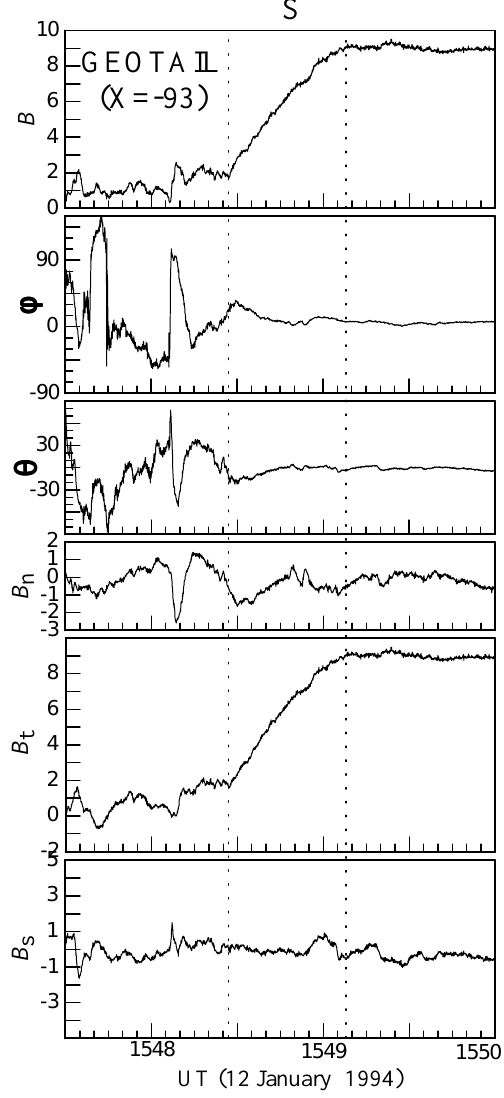
Fig. 4. A stand-alone slow shock was observed on 12 January 1994. The magnetic field vectors inside the shock layer are essentially par- allel to a coplanarity plane. Both the magnitude and the tangential component of the magnetic field, B and B t , decrease monotonically through the shock